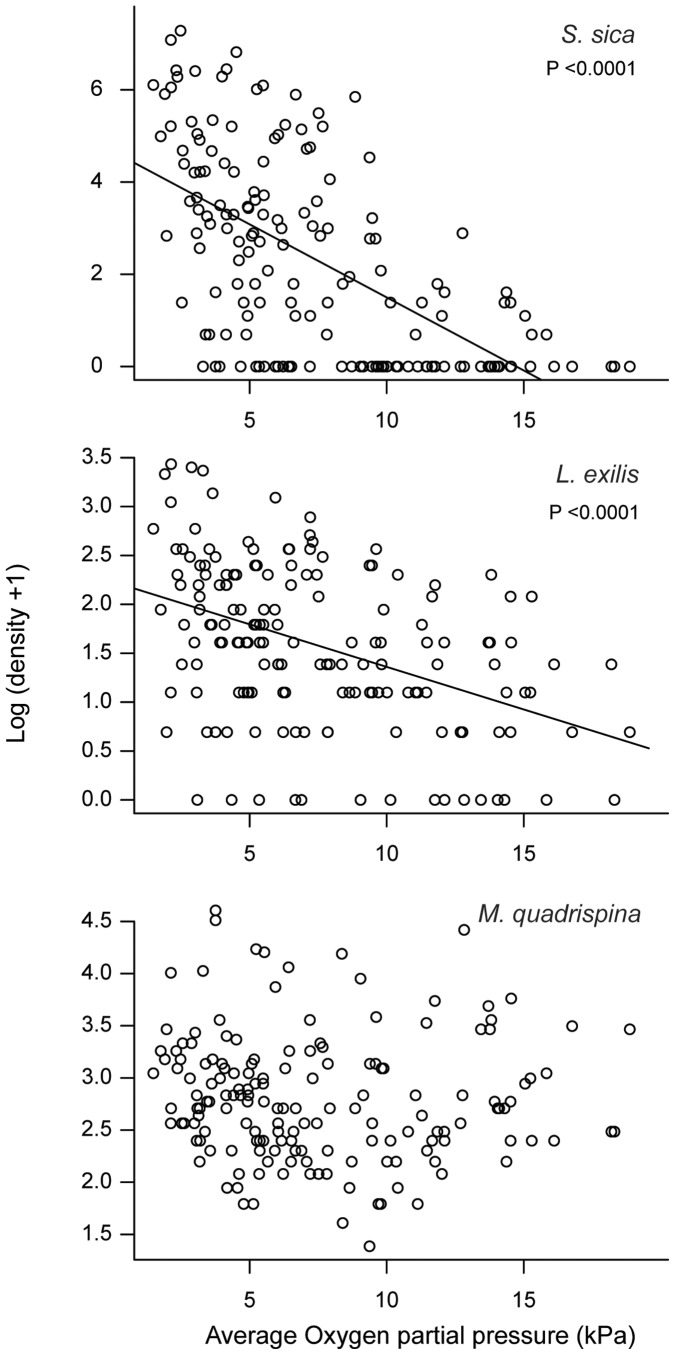
Species abundances relationship with DO concentration’s at the camera site in Saanich Inlet.Relationship between hourly mean oxygen concentration and species abundances for the shrimp Spirontocaris sica (upper), the flatfish Lyopsetta exilis (middle) and the squat lobster Munida quadrispina (lower) in Saanich Inlet.